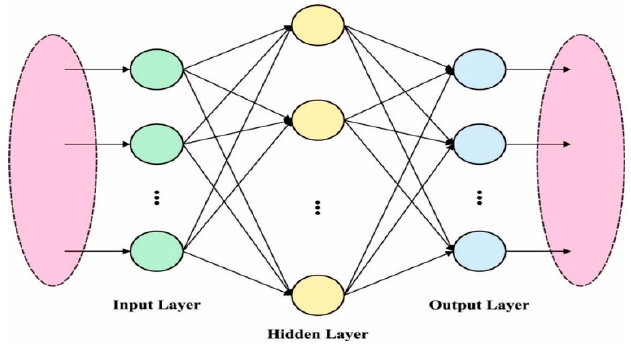
Figure 2. The structure of ELM.